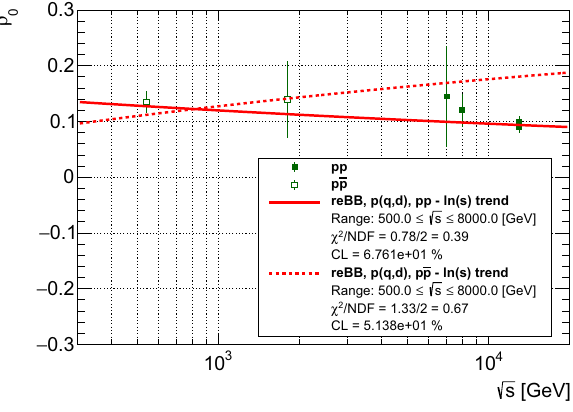
Fig. 15 Sanity test result for pp [7,56,65] and p ¯ p [50] parameter ρ 0 data, as calculated from the model when the values of the parameters R q , R d , R qd and α were taken from Eq. (10) and Table 2, corresponding to the linear curves shown on panels (a)–(d) of Fig.6. On this plot, a model dependent Odderon effect is clearly identified: it corresponds to ρ pp ( s ) (cid:4)= ρ p ¯ p ( s ) , the non-vanishing difference between the excitation 0 0 functions of ρ 0 for pp and ρ 0 for p ¯ p collisions, as detailed in Appendix